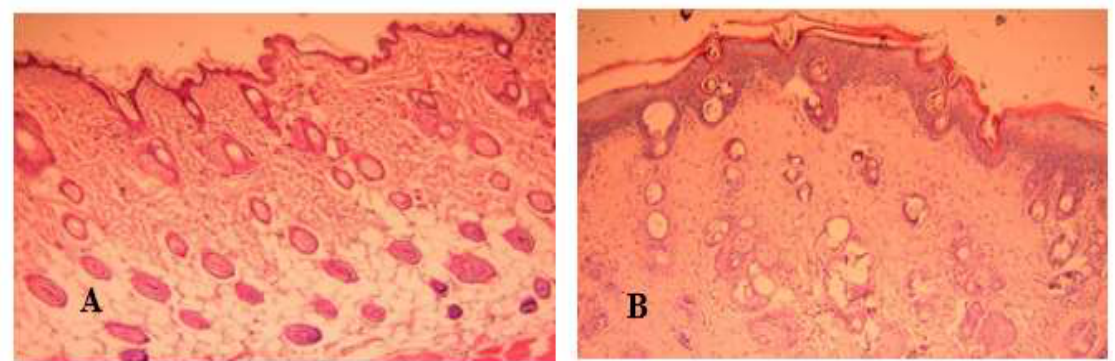
Figure 5. Histopathological changes in topically AD induced group (B) in comparison with phenolic compound of Salvia frigida treated group (A) (10x): ordinary Hematoxylin and eosin stain.